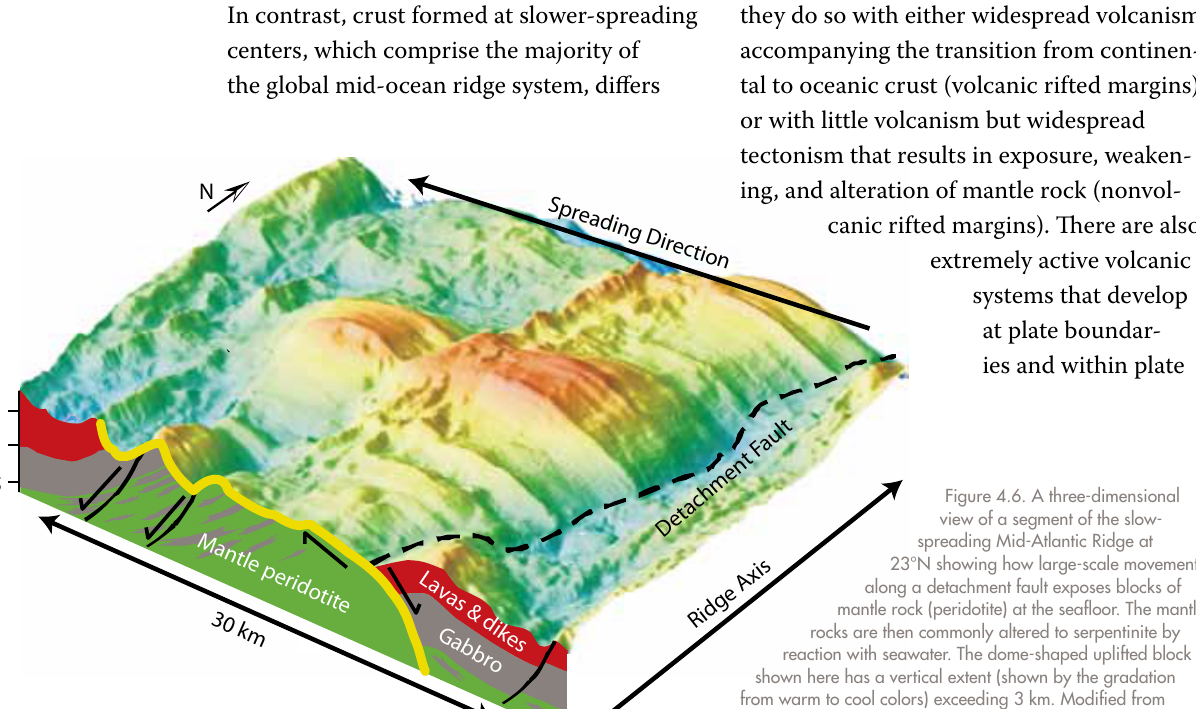
figure 4.6. a three-dimensional view of a segment of the slow- spreading mid-atlantic ridge at 23°n showing how large-scale movement along a detachment fault exposes blocks of mantle rock (peridotite) at the seafloor. The mantle rocks are then commonly altered to serpentinite by reaction with seawater. The dome-shaped uplifted block shown here has a vertical extent (shown by the gradation from warm to cool colors) exceeding 3 km. modified from cheadle and grimes